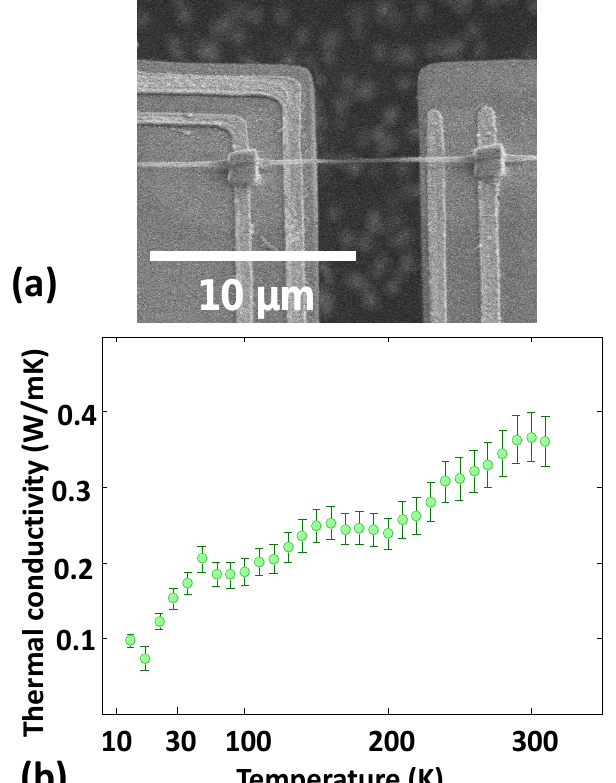
Figure 13. ( a ) NF attached by a platinum coating using FIB. ( b ) The thermal conductivity values of NF prepared by this procedure are similar to bulk PE due to the damage in the NF chains. Adapted from reference [3] supplementary information.